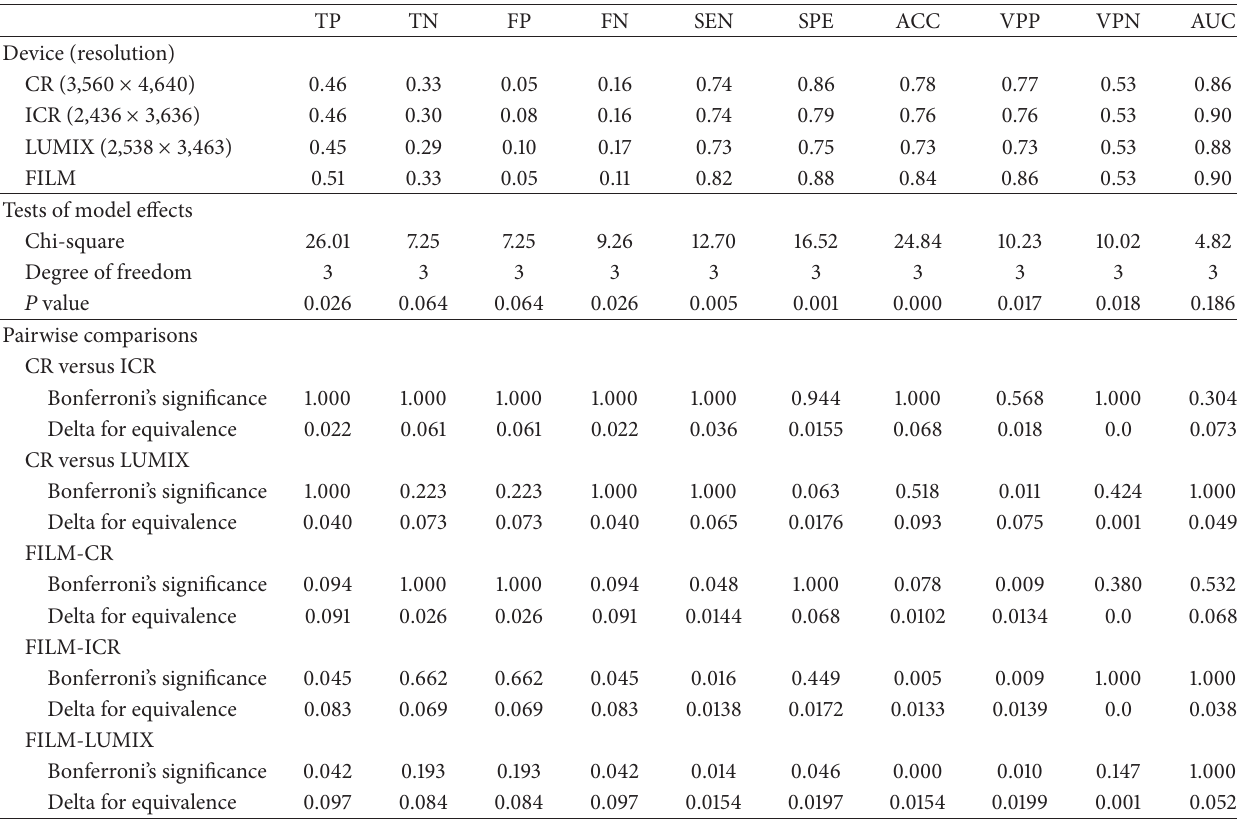
Table 8: Evaluation of dense breasts. Mean values, pairwise comparisons, and observed delta for equivalence for TP, TN, FP, sensitivity, specificity, accuracy, VPP, VPN, and AUC.